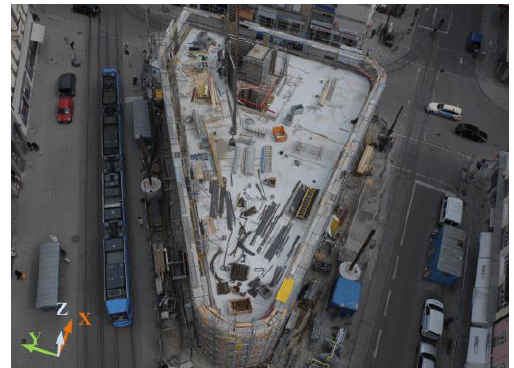
Figure 10. Imagery of the construction site taken from the crane.